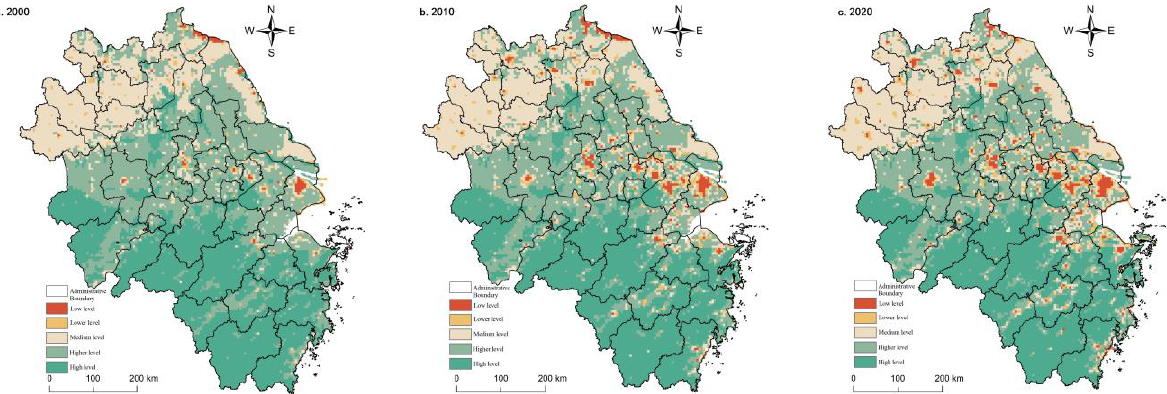
Figure 6. Spatial pattern of ecological functions in the Yangtze River Delta region from 2000 to 2020.